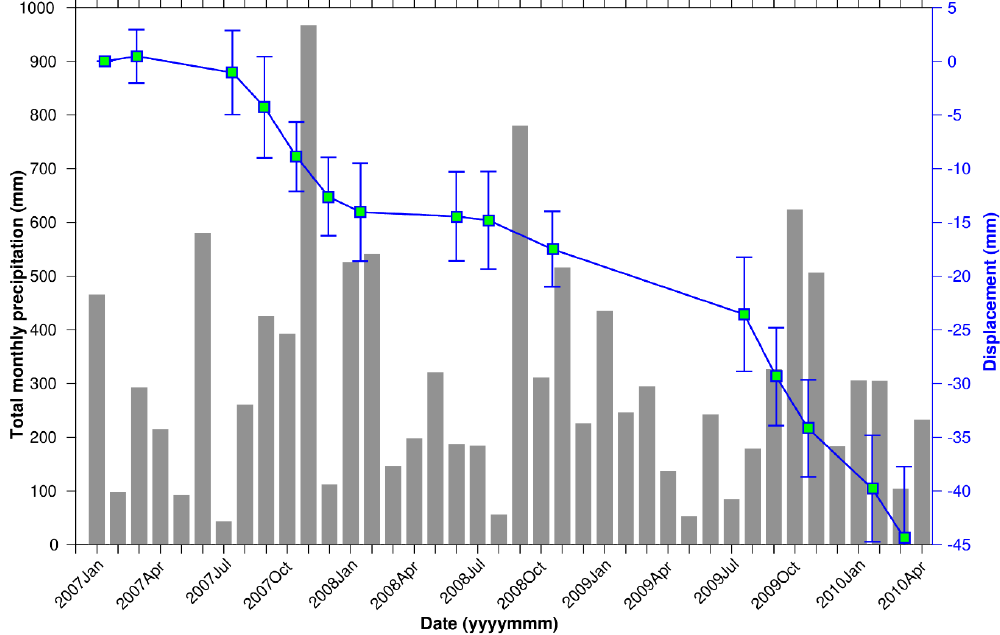
Figure 11. Comparison of the incremental downslope displacement (blue lines) with the average monthly precipitation (gray histogram). monthly precipitation (gray